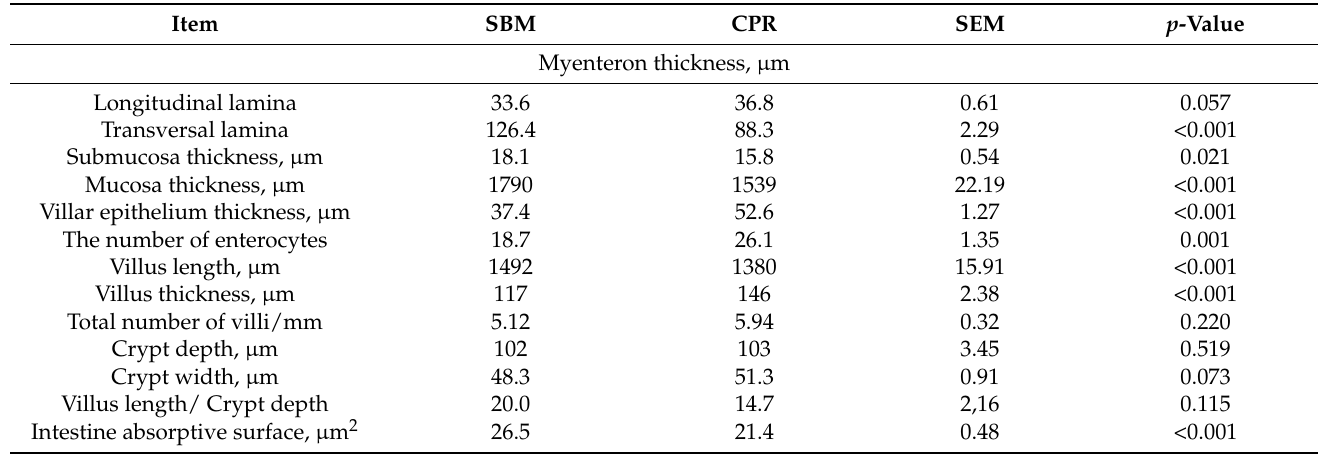
Table 2. Effect of raw chickpea on histomorphometric parameters of the duodenum in 42-day-old broiler chickens 1